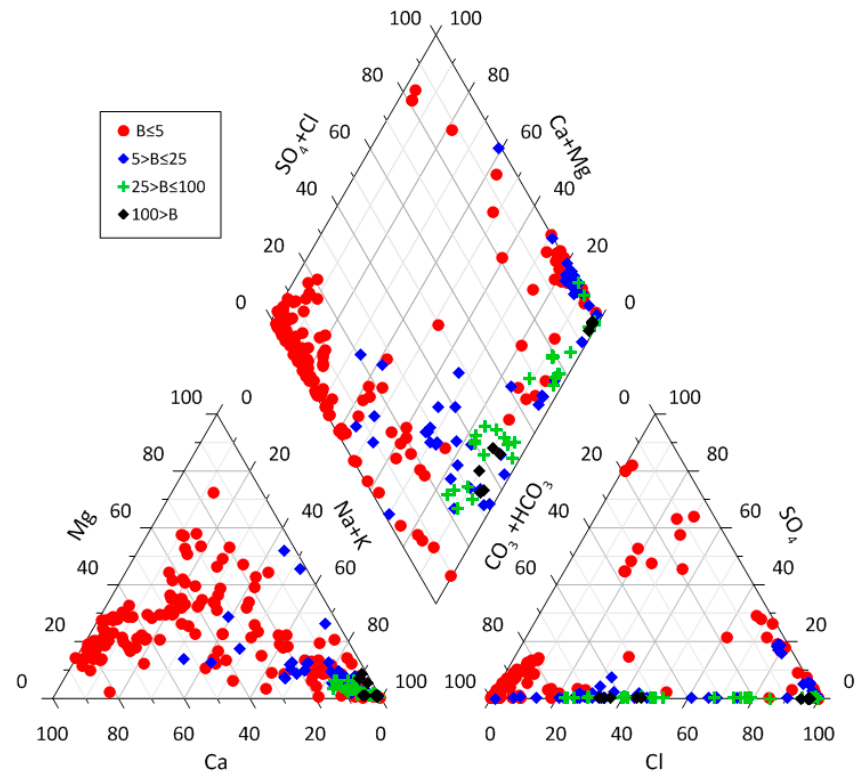
Figure 6. Piper diagram of curative water.